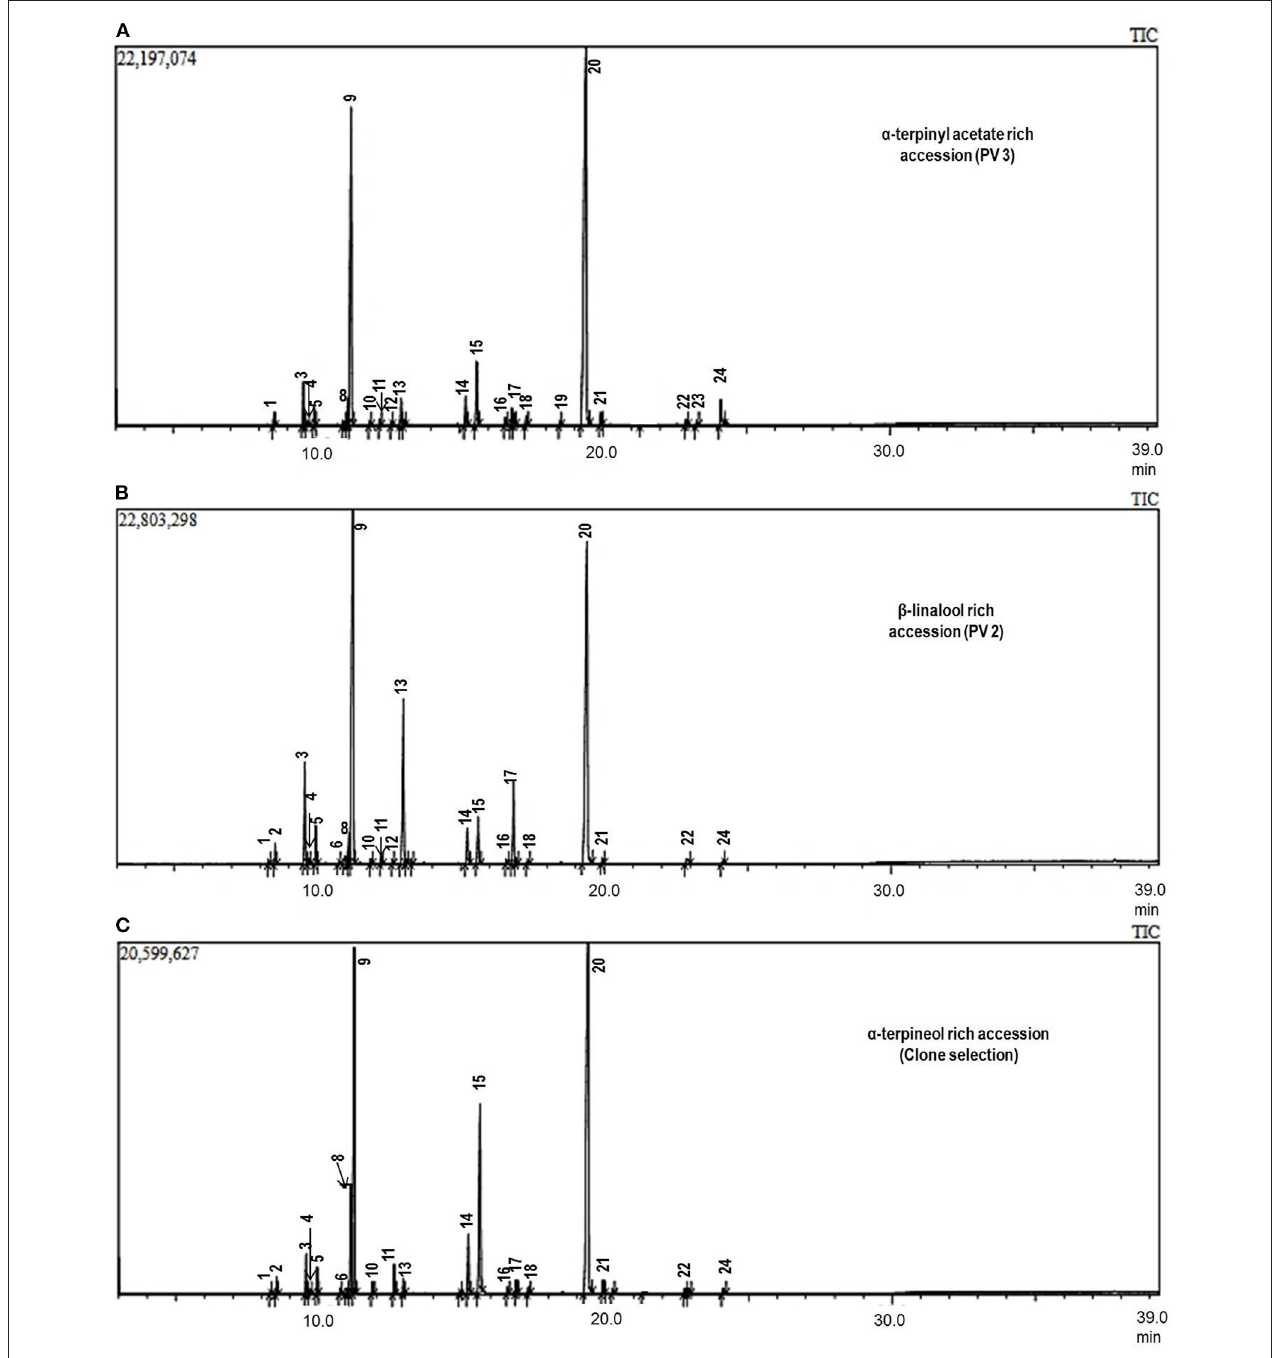
FIGURE 2 | Essential oil chromatogram of chemovariants of Elettaria cardamomum (L.) Maton: (A) α -terpinyl acetate-rich chemotype, (B) β -linalool rich chemotype, and (C) α -terpineol rich chemotype.